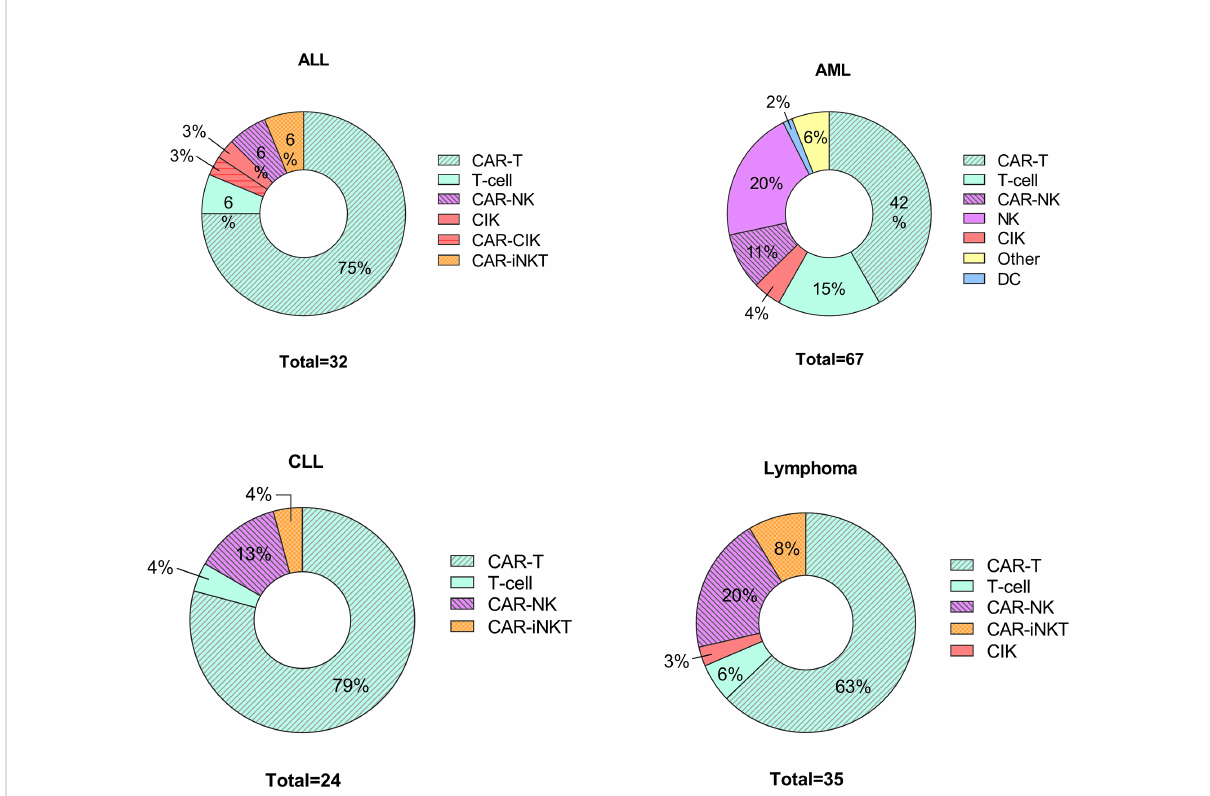
FIGURE 2 Cell-based therapies in hematological disorders. Graphical representations of clinical trials of adoptive cell transfer in